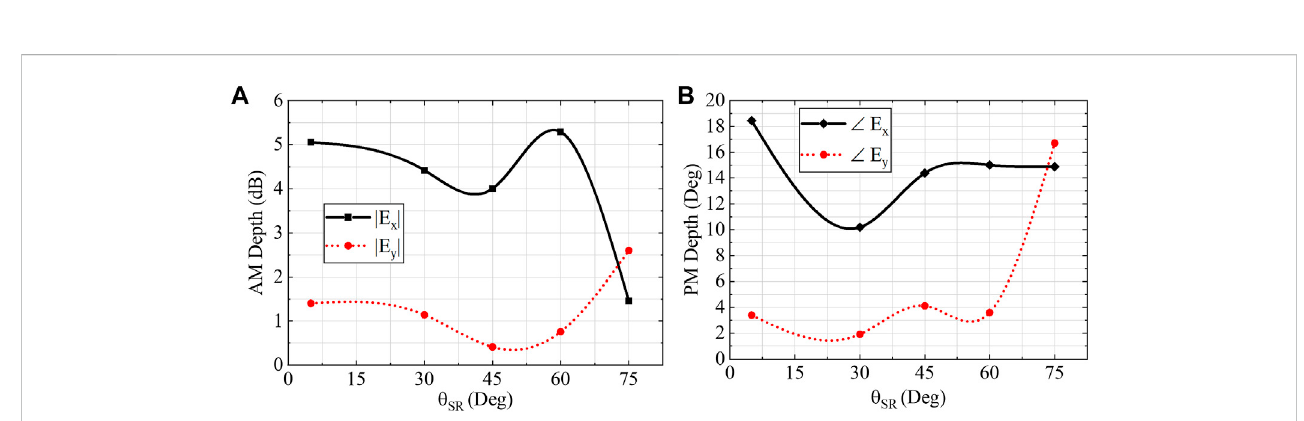
FIGURE 6 Spectral AM depth for the 0.74 THz frequency (A) and PM depth for the 0.68 THz frequency (B) when processing only the fi rst temporal pulse.